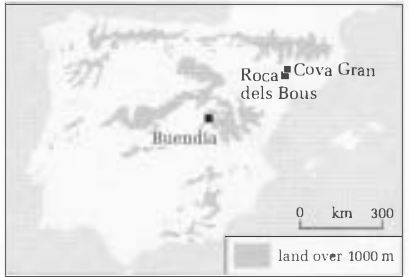
Figure 4 The location of the sites studied in the Iberian